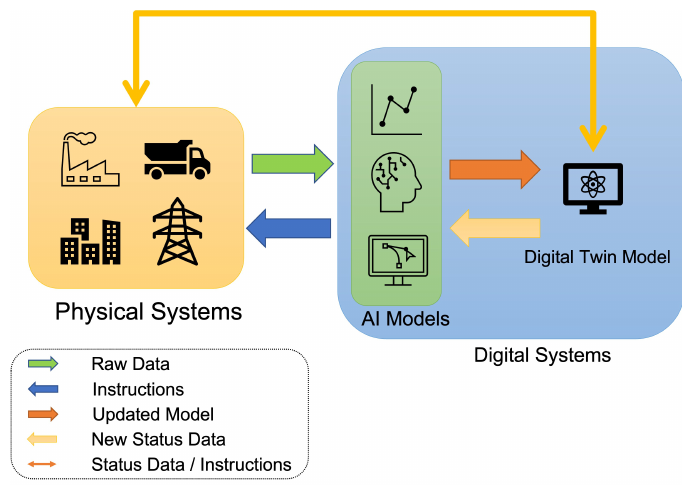
Figure 7. DT-based